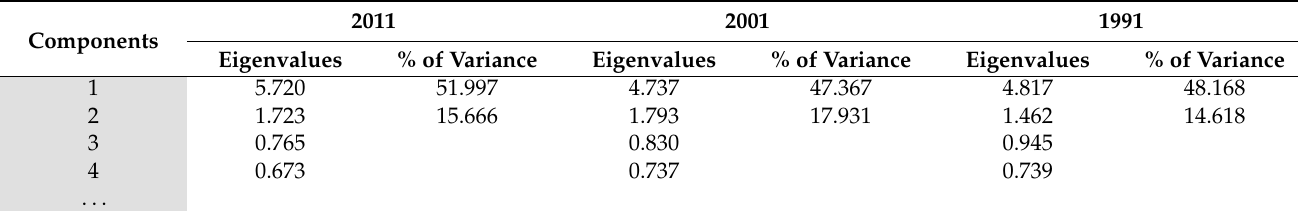
Table 2. PCA eigenvalues and variance explained.